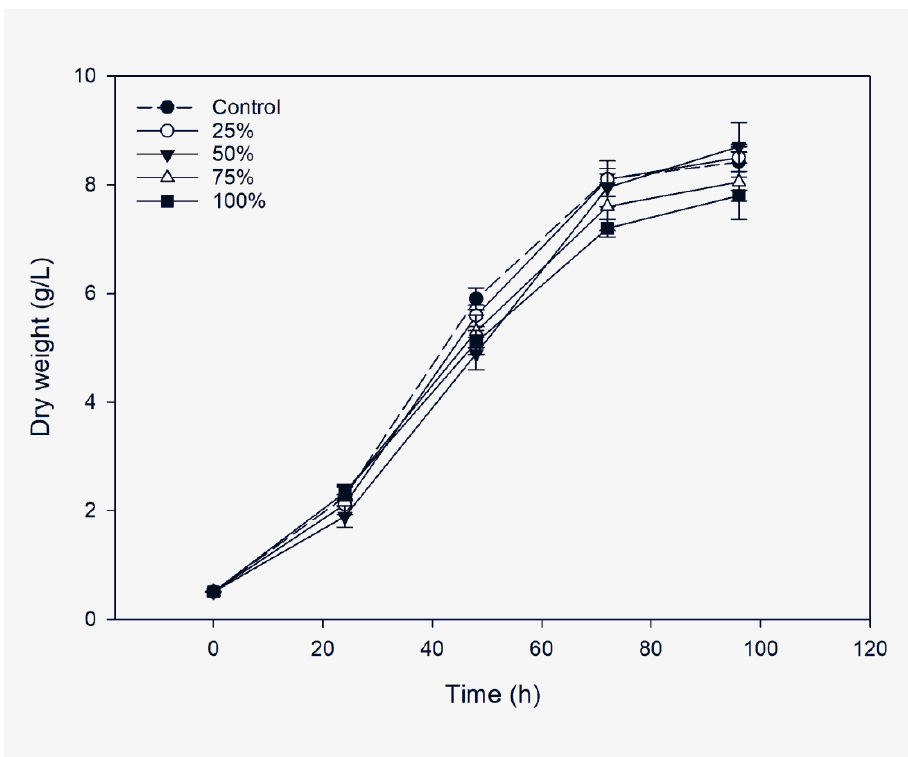
Figure 3. Growth curves of A. mangrovei using the new media with progressive substitution (25–100%) of standard glucose with sugars from spent osmotic solution. 100% substitution means that the only organic carbon sources were sugars from SOS.